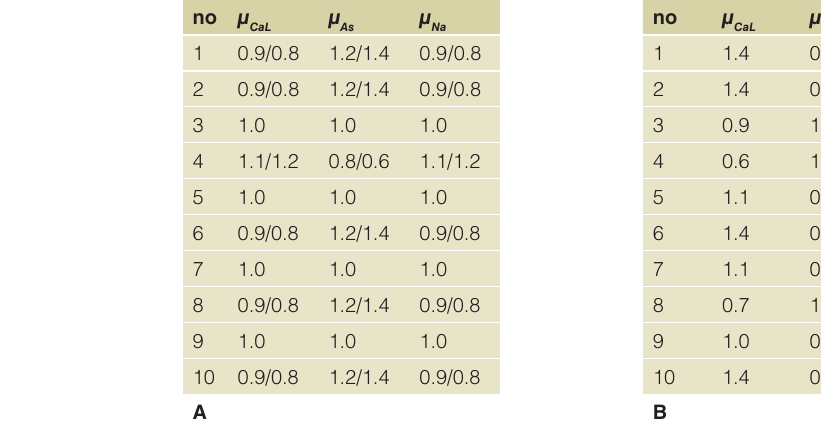
Table 3. Pattern learning: Parameter values (A) for positive learning with (weak/ strong) adaptation of μ values and (B) negative learning. CaL and Na channels are adapted in the opposite direction to K channels.